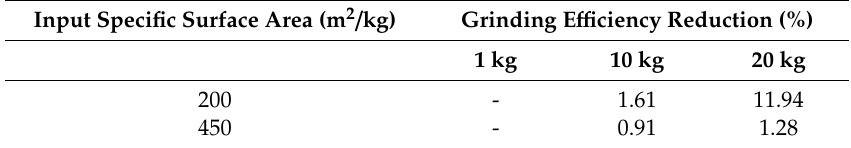
Table 3. Reduction of grinding e ffi ciency.